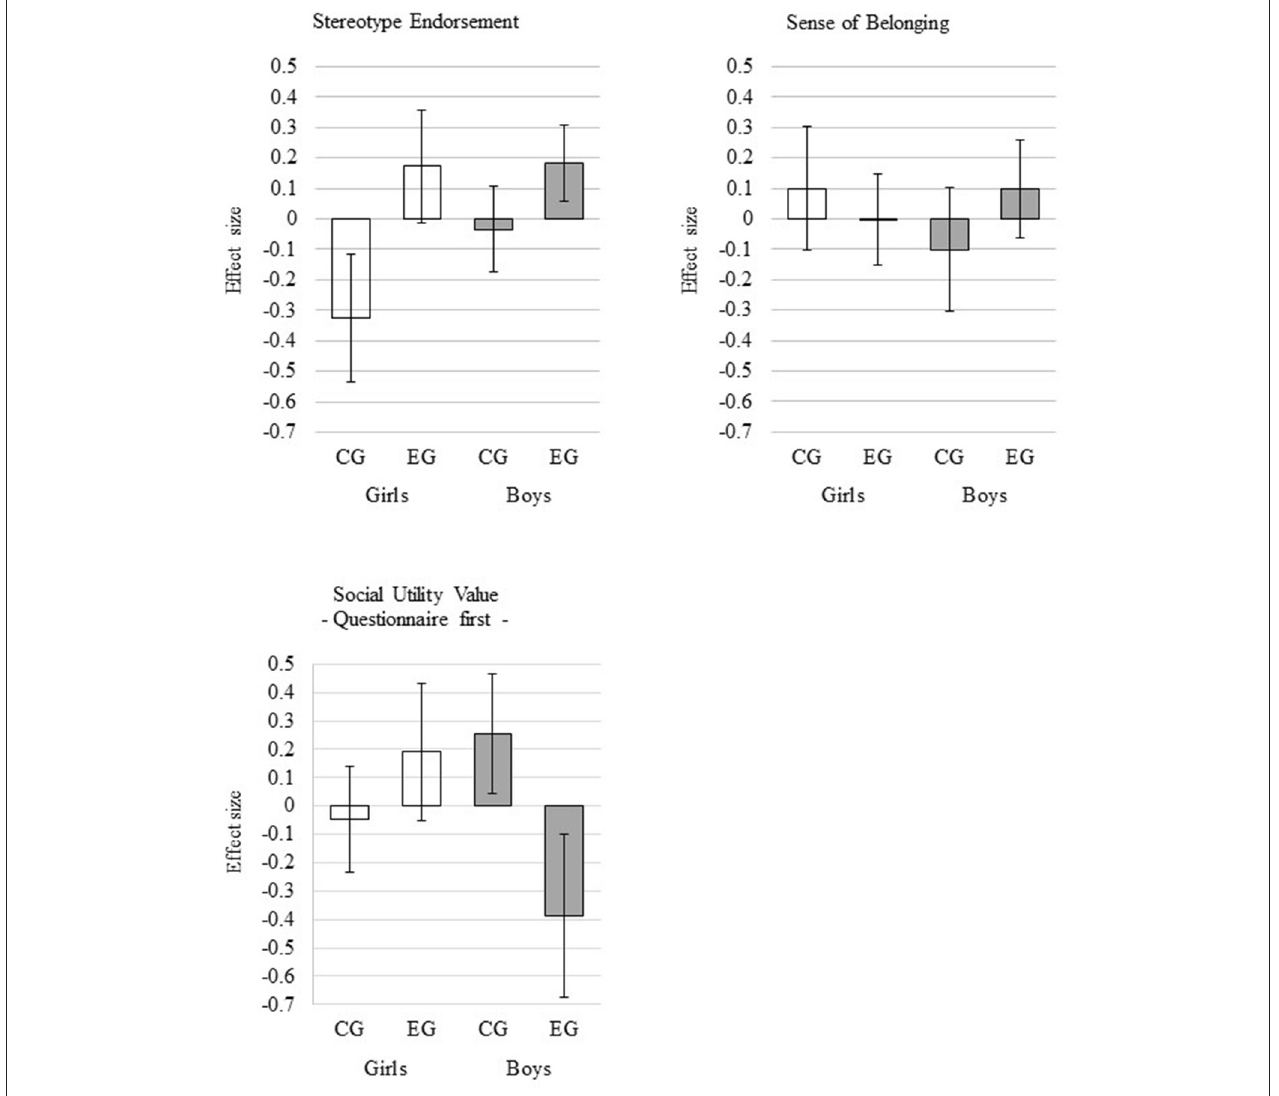
FIGURE 1 | Effects of the experimental manipulation. Error bars represent 95% confidence intervals. CG = control group; EG = experimental